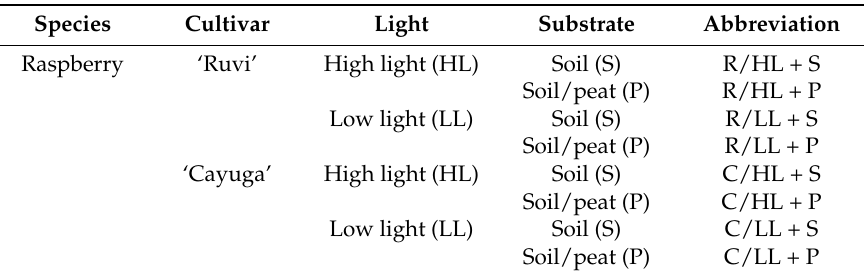
Table 1. Raspberry cultivars (‘Ruvi’ and ‘Cayuga’) and experimental conditions (light, substrate) used in the present